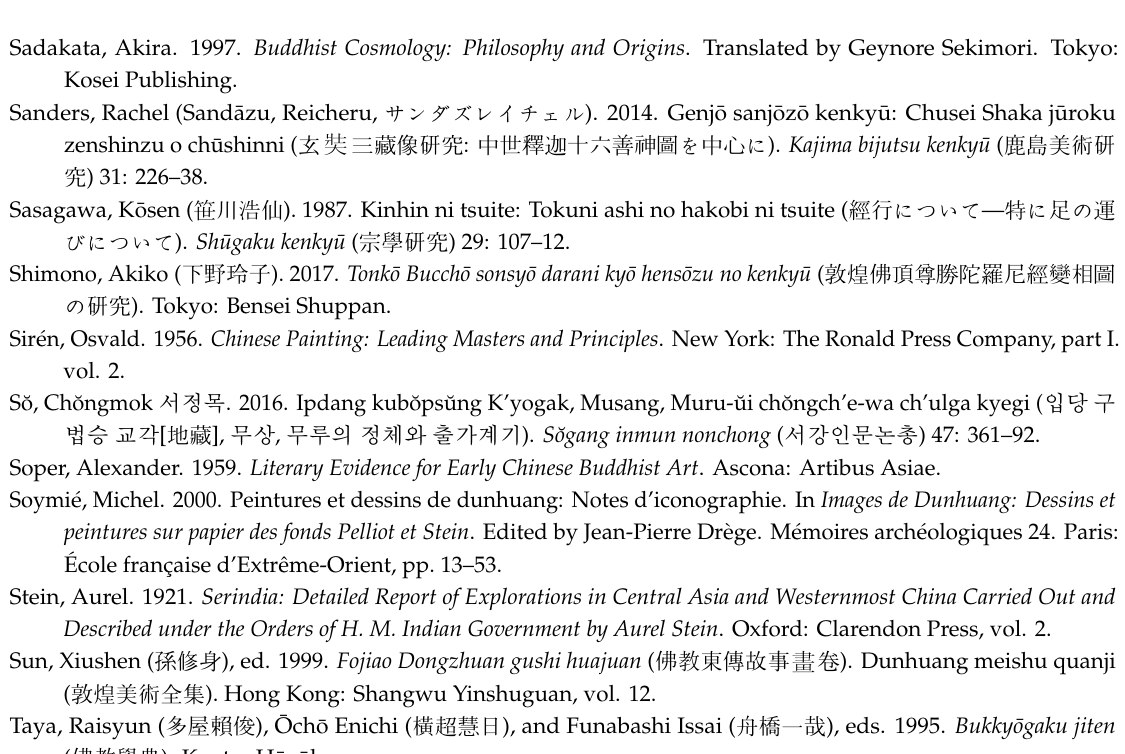
Figure 7. Itinerant Monk . Dunhuang, 10th century. Ink and colors on paper, 51.8 × 29. 3 cm. Inv. No. Photo by Leonard